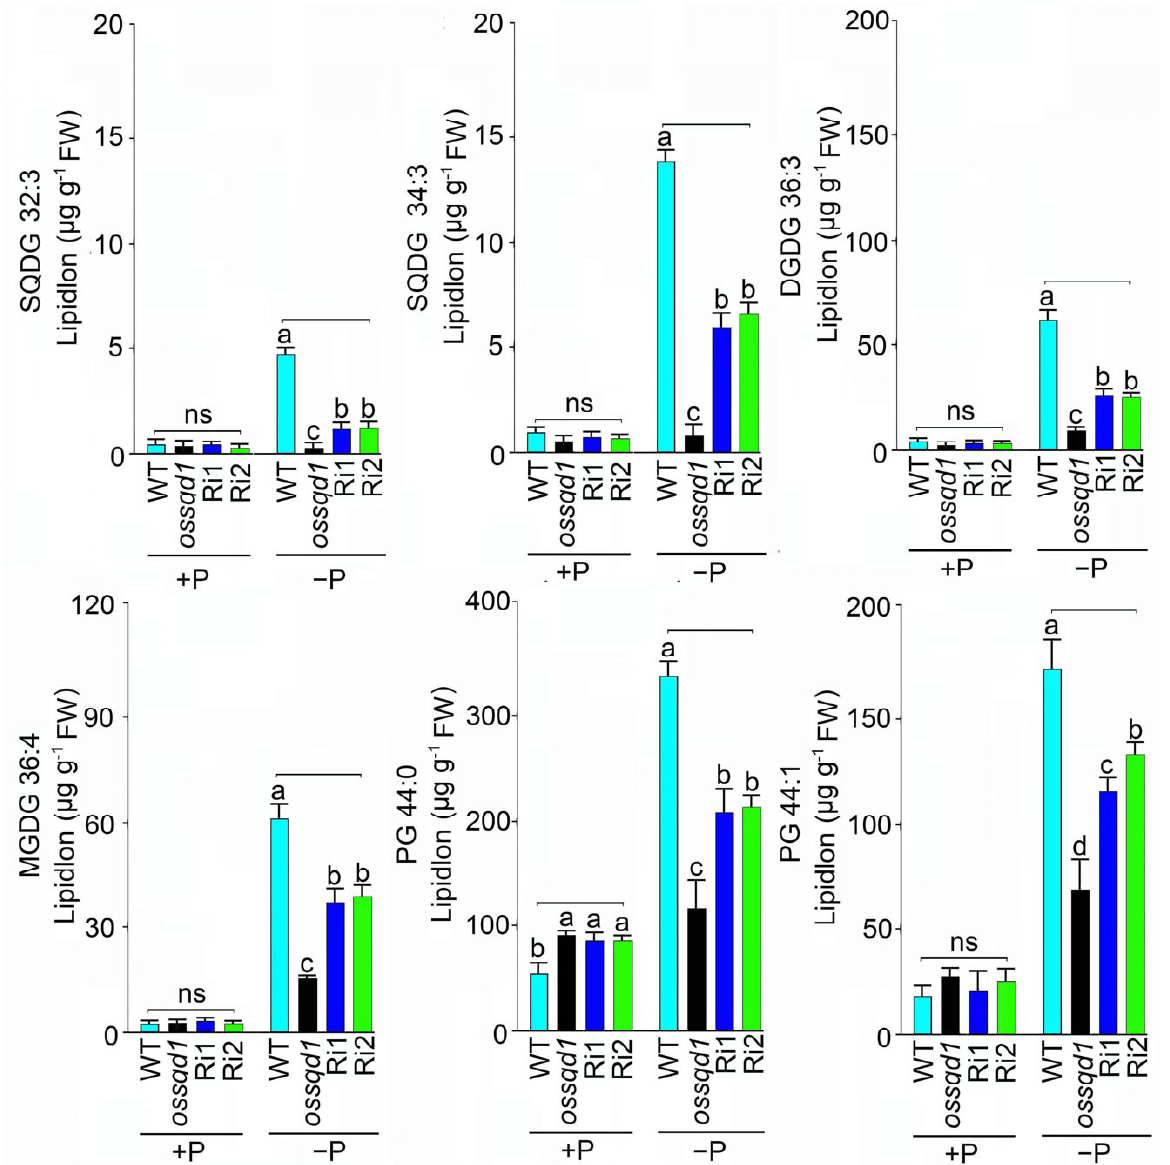
Figure 5. Knockout/down of OsSQD1 decreased the fatty acid concentration of different phospho- lipids and glycolipids in roots under − P condition. Values are means ± SE ( n = 4). Different letters indicate that the values differ significantly between WT, ossqd1 mutant, Ri1 and Ri2 ( p < 0.05, one-way analysis of variance, Duncan’s test). ns = not significant.